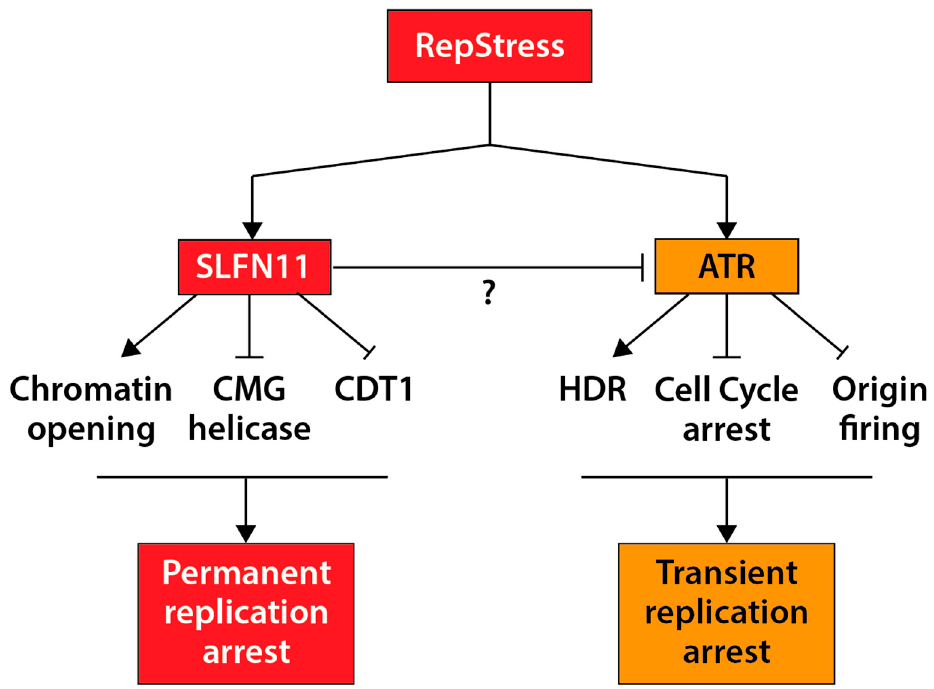
Figure 1. The SLFN11 and ATR pathways in response to RepStress. SLFN11 irreversibly blocks DNA replication under RepStress by promoting chromatin opening, blocking the CMG helicase complex, and promoting the degradation of CDT1 (see Section 5.1 for details). In contrast, ATR transiently halts DNA replication by arresting cell cycle and prohibiting origin firing, thereby enabling homology ‐ directed repair (HDR).